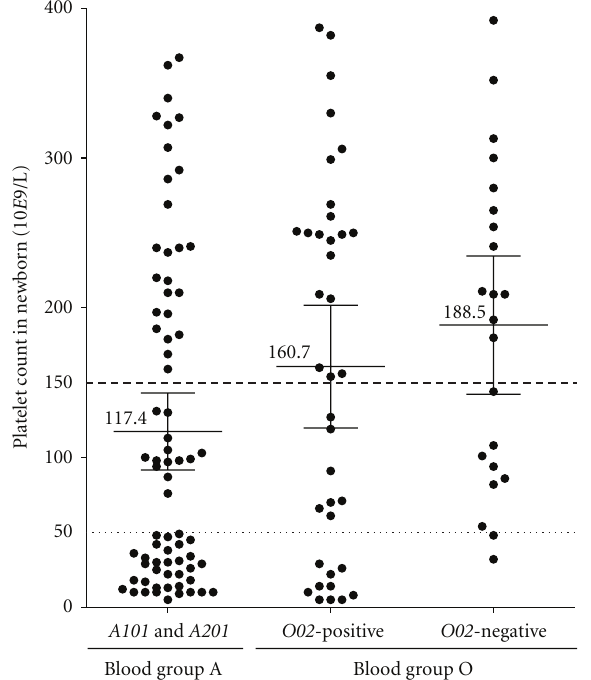
Figure 1: The platelet count at delivery in HPA-1a-positive new- borns was grouped according to maternal ABO type (A or O). Platelet count ≤ 150 × 10 9 /L (dashed line) is defined as NAIT and < 50 × 10 9 /L (dotted line) as severe NAIT. The mean platelet counts in the three groups are indicated, with error bars representing 95% CI. Mean platelet counts are significantly di ff erent ( P < 0 . 019, one-way ANOVA). The mean antibody levels between these groups are not significantly di ff erent: 11.6IU/mL for blood group A mothers, 11.1 IU/mL for O02 -positive blood group O mothers, and 1.8IU/mL O02 -negative blood group O